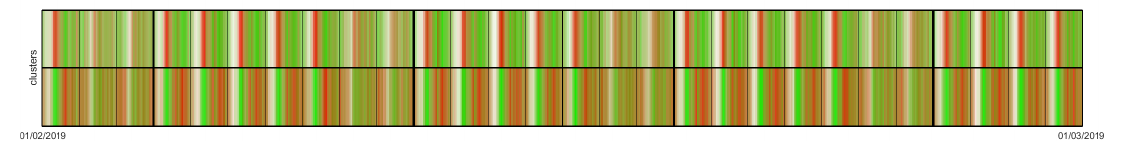
Figure 4. Colour map for 2